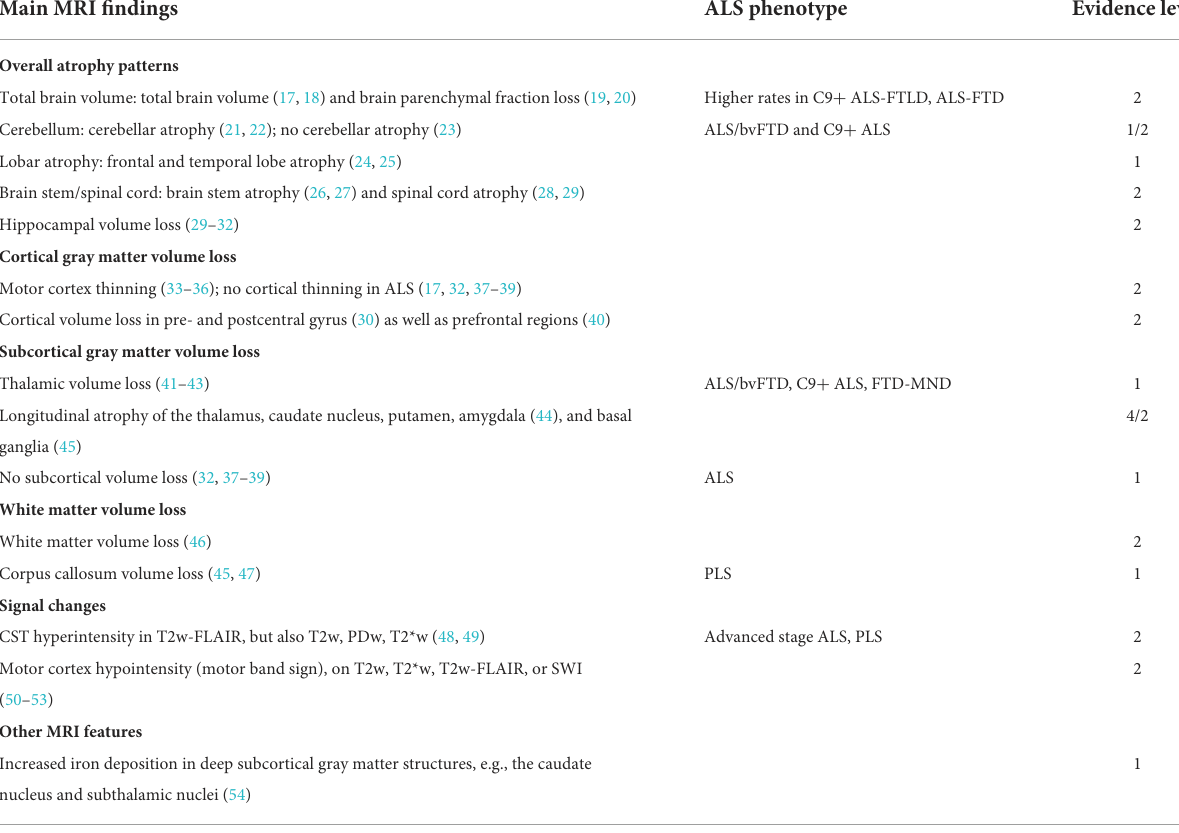
TABLE 1 Synopsis of brain and spinal cord MRI findings in human motor neuron disease studies. Main MRI findings ALS phenotype Evidence